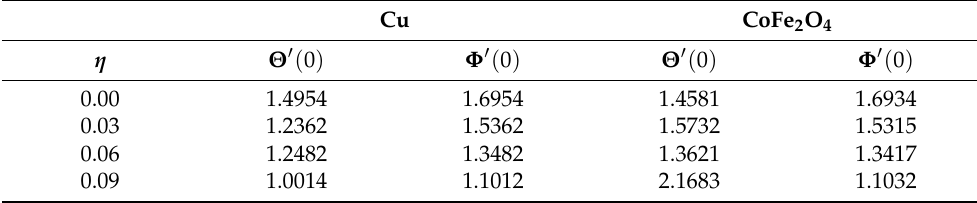
Table 5. Statistical assessments of Sherwood and Nusselt